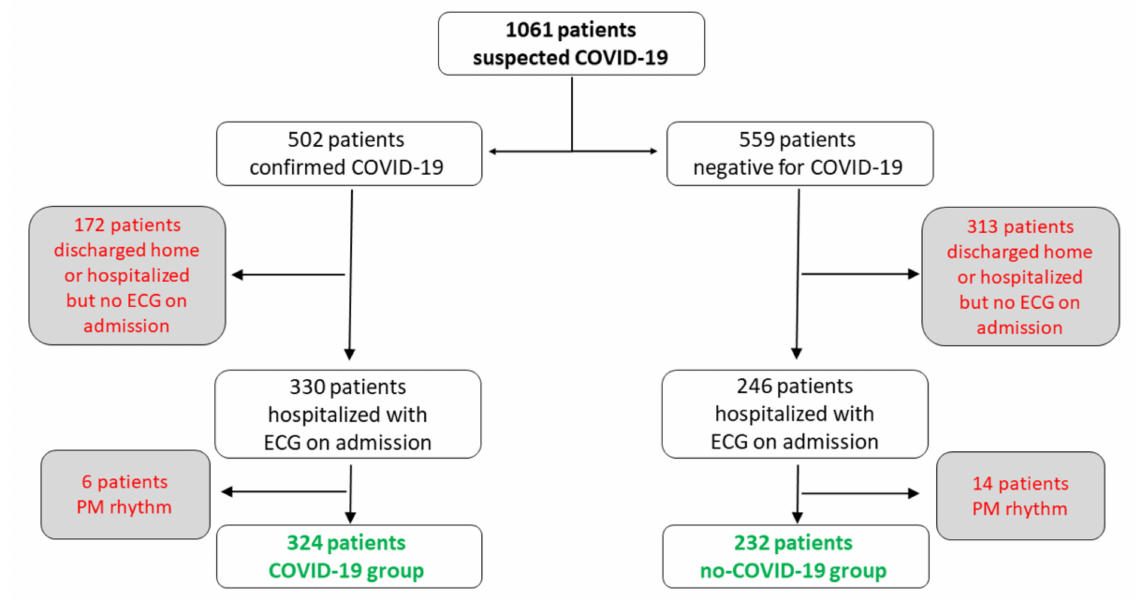
Figure1. Flow-chartofpatients’enrolment.COVID-19 = coronavirusdisease2019;ECG = electrocardiogram; PM =